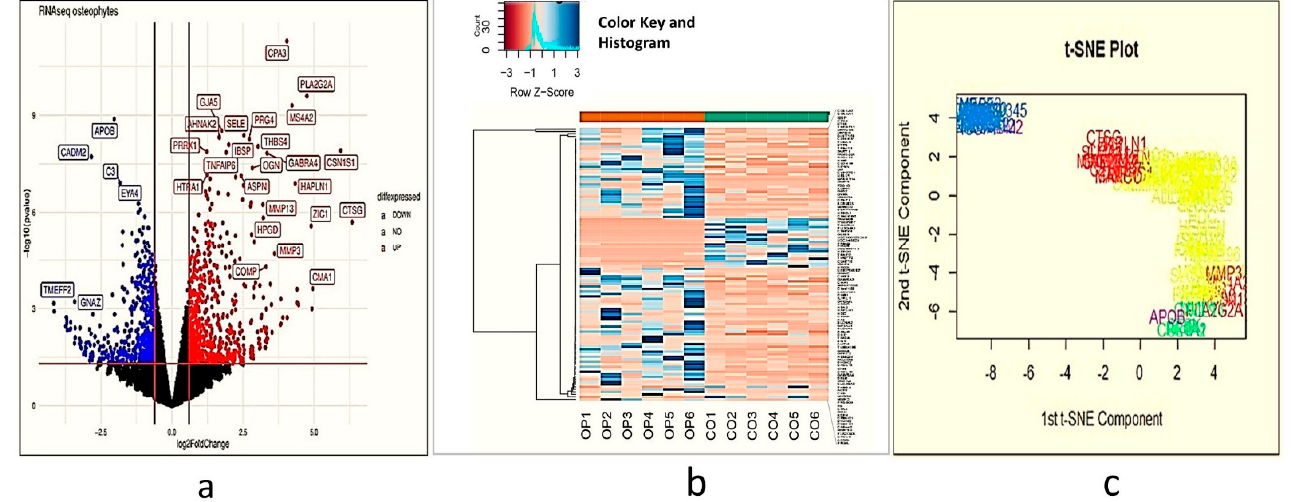
Figure 1. Demonstrate an overview of differentially expressed genes in transcriptome analysis performed using osteophyte samples and non-osteophytic control tissue obtained from six knee OA patients ( n = 595). ( a ) Volcano plot of the differentially expressed genes. Here, black dots represent insignificant genes, while blue and red dots represent down-regulated and up-regulated genes, respectively. The plot is generated using LogFC values of the expressed genes. Carboxypeptidase A3 (CPA3), selectin E (SELE), membrane-spanning 4-domains A2/Fc fragment of IgE receptor 1a (MS4A2/FCERI), chymase 1 (CMA1), interleukin 1 receptor-like 1 (IL1RL1), collagen type 1 alpha 1 chain (COL1A1), COL1A2, matrix metalloproteinase 1 (MMP-1), MMP-3 and MMP-13 are among the significantly upregulated genes; ( b ) Histogram of the highly significant genes, which were obtained after K-means cluster analysis; ( c ) t-SNE plot of ‘highly differentiated’ genes (generated after K-means cluster analysis). t-SNE is a dimensional reduction technique of presenting large gene data sets; we generated a two-dimensional t-SNE plot to verify the cluster analysis. For this, we considered logFC, logCPR and p -values of the highly significant genes in the osteophyte specimens.